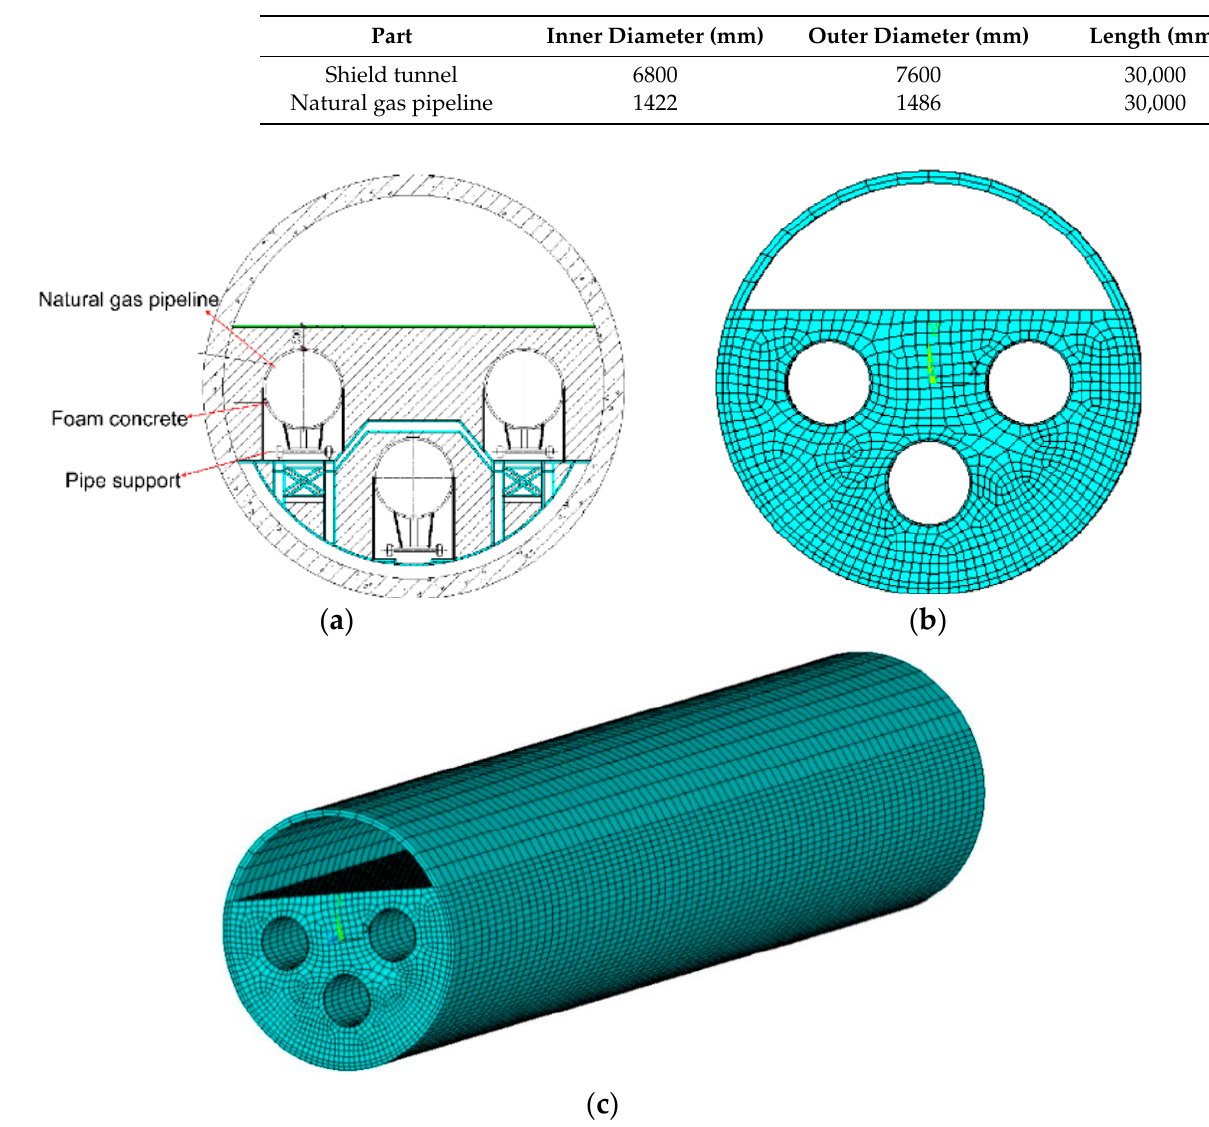
Table 10. Model parameters for foam concrete-filled tunnels.